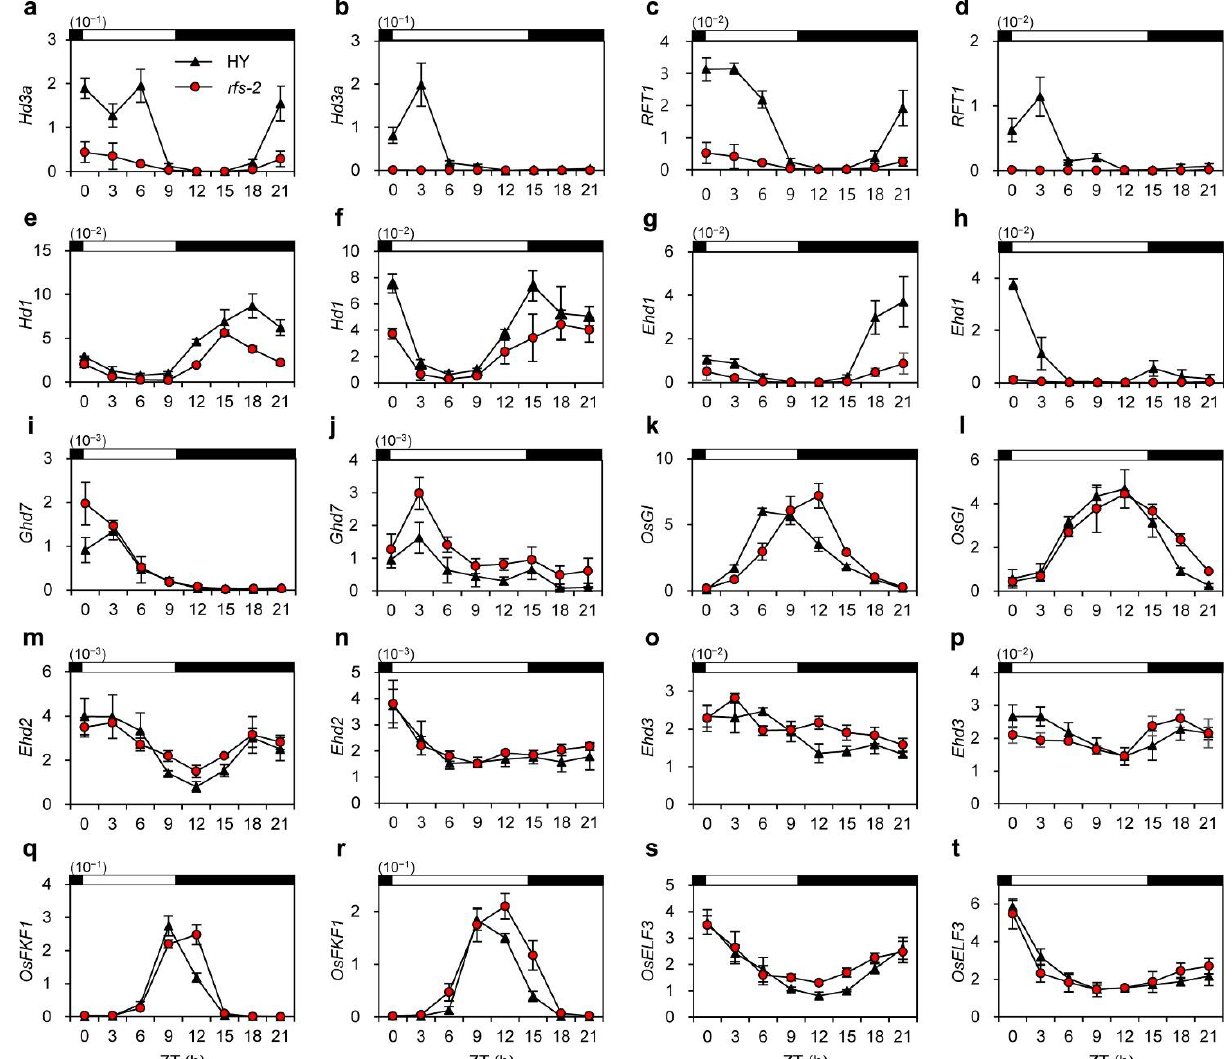
Figure 4. Diurnal expression of flowering genes in the rfs-2 mutant. Rice plants were grown for 25 days after sowing (DAS) in SDs ( a , c , e , g , i , k , m , o , q , s ) and 80 DAS in LDs ( b , d , f , h , j , l , n , p , r , t ). Total RNA was isolated from the leaf blades collected every 3 h during a 24-h period. Transcript levels of Hd3a ( a , b ), RFT1 ( c , d ), Hd1 ( e , f ), OsGI ( g , h ), Ehd1 ( i , j ), Ghd7 ( k , l ), Ehd2 ( m , n ), Ehd3 ( o , p ), OsFKF1 ( q , r ), and OsELF3 ( s , t ) were determined by RT-qPCR and normalized to that of OsUBQ5 ( LOC_Os01g22490 ). The open and filled bars at the top of graphs represent light and dark periods, respectively. Means and standard deviations were obtained from three biological replicates. The experiments were repeated three times with similar results. ZT, zeitgeber time (hours after dawn).